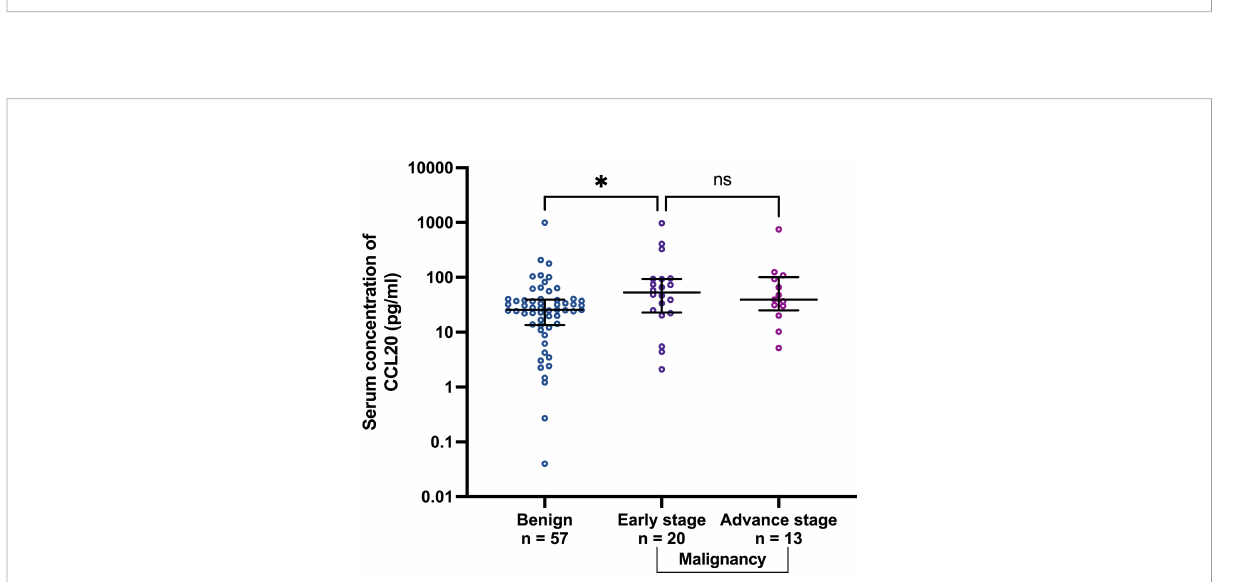
FIGURE 3 Scatter plots of CCL20 concentrations in benign group comparing with early stage (stage I and II) and advanced stage (stage III and IV) malignancies. *p<0.05; not signi fi cant (ns). The lower and upper whiskers are the interquartile ranges, and the middle line is the median.